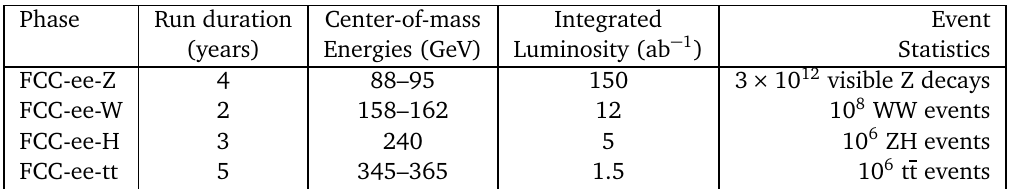
Table 1: Run plan for FCC-ee in its baseline configuration with two experiments